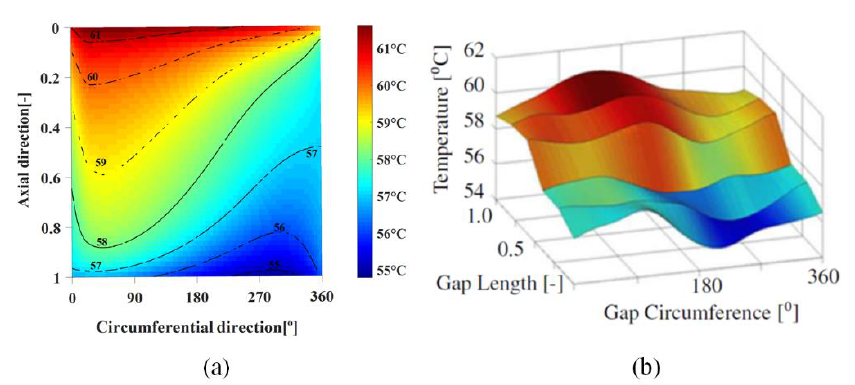
Figure 8. Velocity distribution.